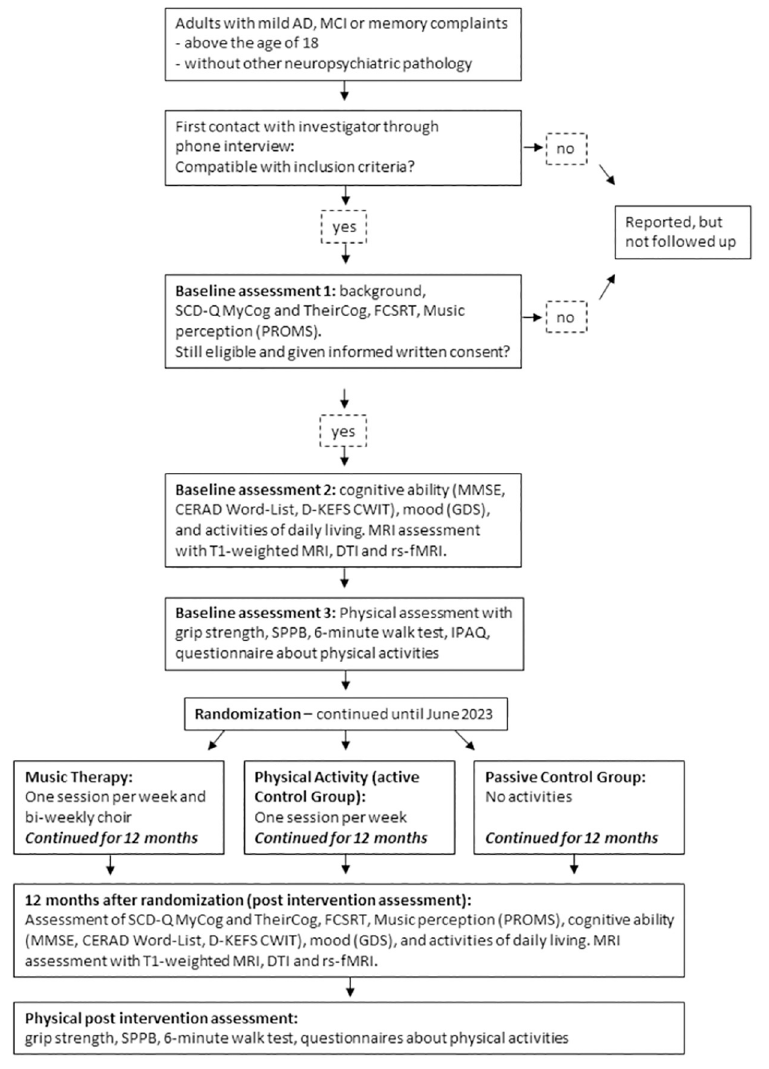
Fig 2. Flow chart of the study design. Abbreviations: AD—Alzheimer’s Disease; MCI—Mild Cognitive Impairment; SCD-Q—Subjective Cognitive Decline-Questionnaire; FCSRT—Free and Cued Selective Reminding Test; PROMS— Profile of Music Perception Skills; MMSE—Mini Mental Status Examination; CWIT—Colour Word Interference Test; GDS—Geriatric Depression Scale; MRI—Magnetic Resonance Imaging; DTI—Diffusion Tensor Imaging; rs-fMRI— resting state functional MRI; SPPB—Short Physical Performance Battery; IPAQ—International Physical Activity Questionnaire.